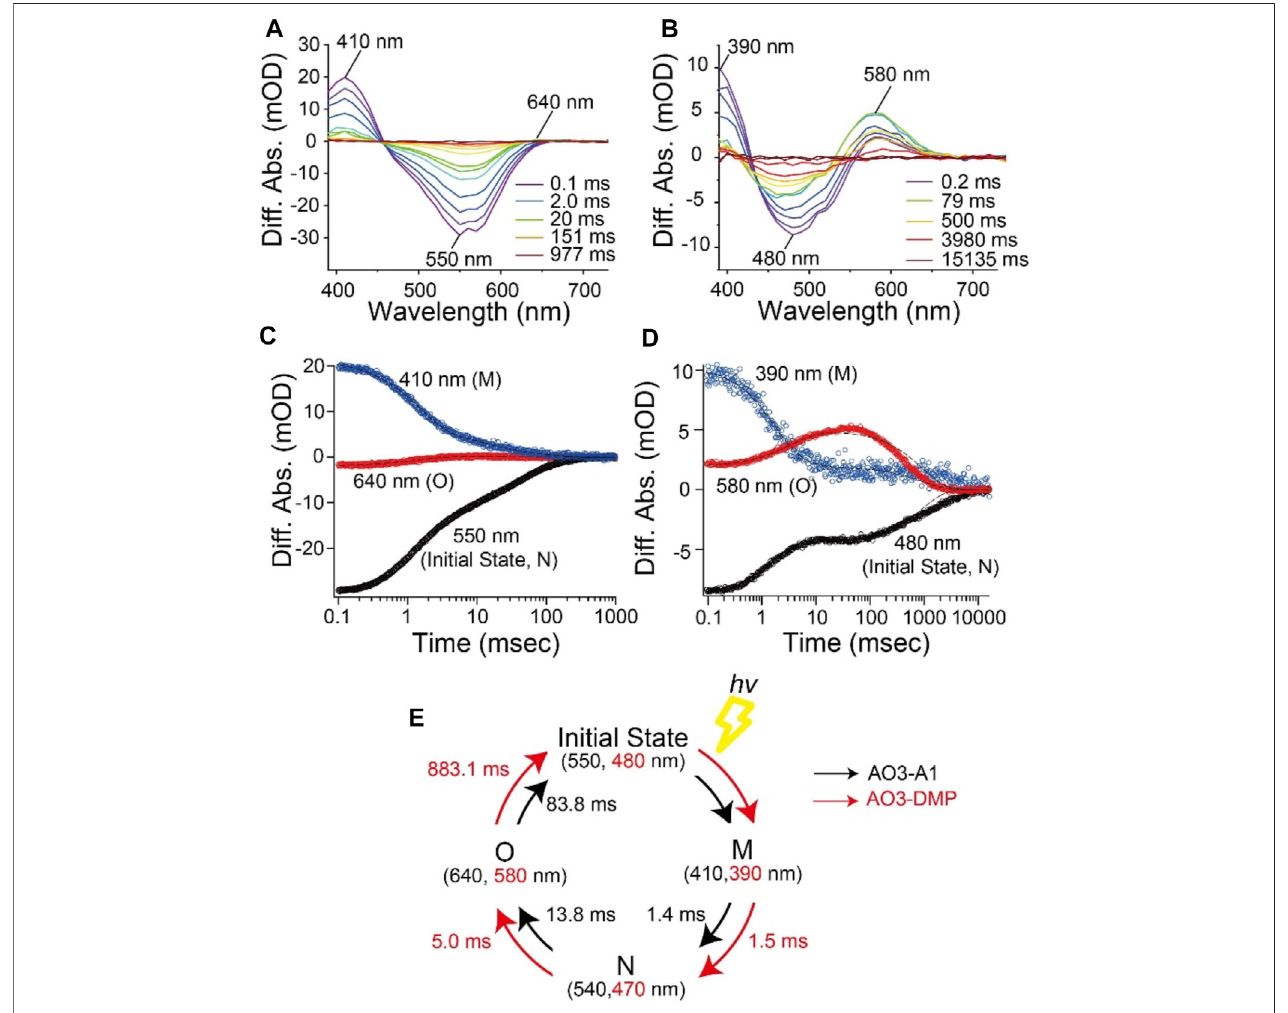
FIGURE 4 | Photocycle kinetics of AO3 with A1-retinal and DMP-retinal. Flash-induced difference absorption spectra of puri fi ed AO3 with A1-retinal (AO3-A1) (A) and DMP-retinal (AO3-DMP) (B) over the spectral range of 390 – 730 nm. The time courses of absorbance changes of AO3-A1 at 410, 550 and 640 nm (C) and absorbance changes of AO3-DMP at 390, 480, and 580 nm (D) , where the black dotted lines show the fi tting curves. (E) A model of the photocycle of AO3-A1 (black) and AO3-DMP (red). The absorption maxima and reaction rates are overlaid.